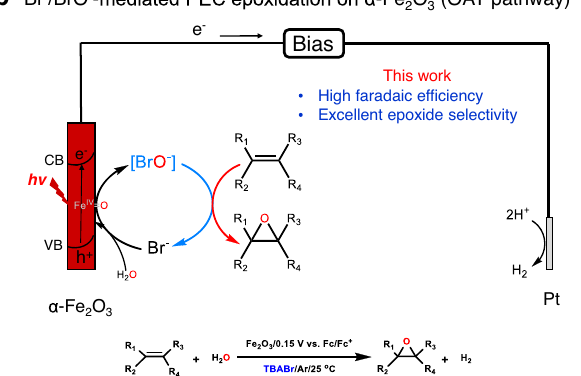
Fig.1|Schematicillustrationsforepoxidationofalkenesbydifferentbromine- mediatedpathways.a Br − /Br 2 -mediated electrochemical epoxidationonPtanode with a pathway of single electron transfer; ( b ) Br − /BrO − -mediated photoelec- trochemical epoxidation on α -Fe 2 O 3 with an oxygen atom transfer